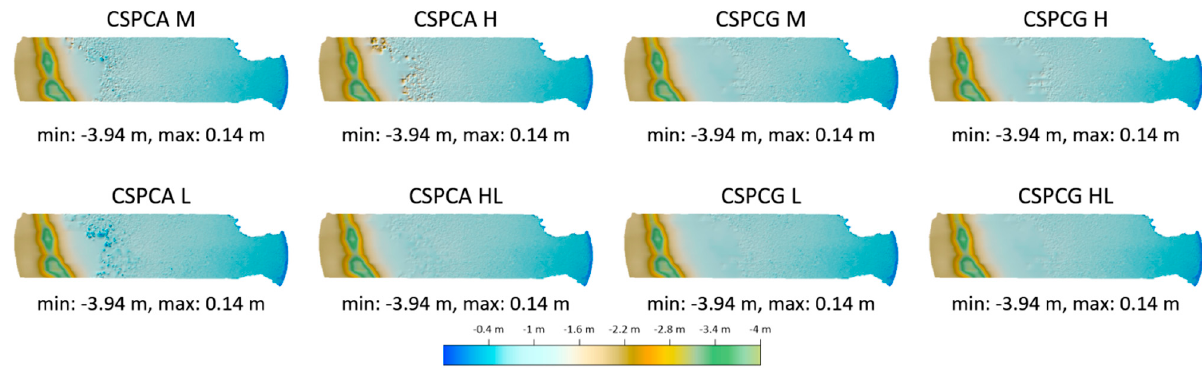
Figure 20. Models obtained using the natural neighbor method.